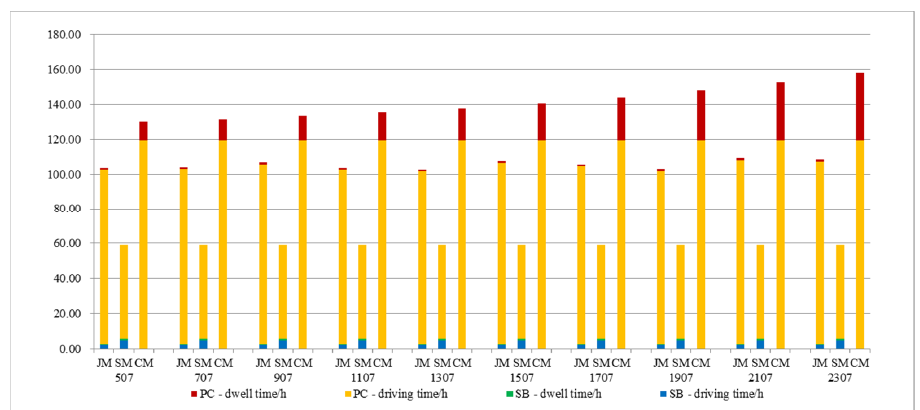
Figure 13. Various cost variations with parameter q .